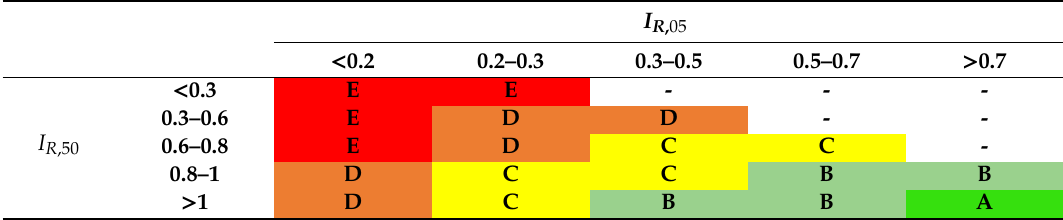
Table 3. Seismic performance classification—definition of